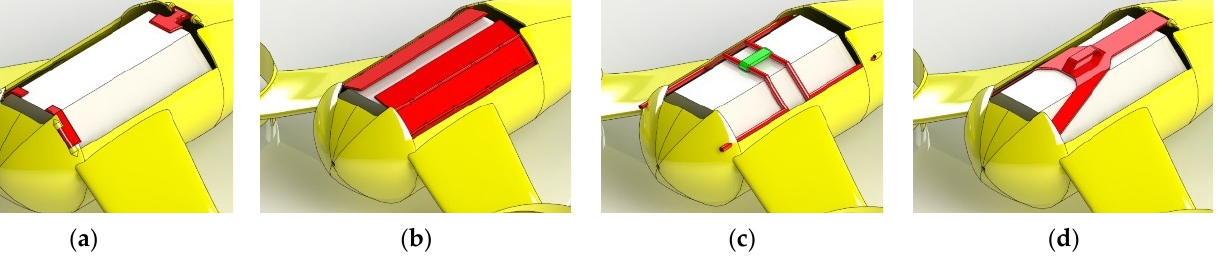
Figure 5. Identified quick-release systems: ( a ) clamp-based solution ( b ) shutter-like system, ( c ) cage- based architecture, and ( d ) Y-like structure.